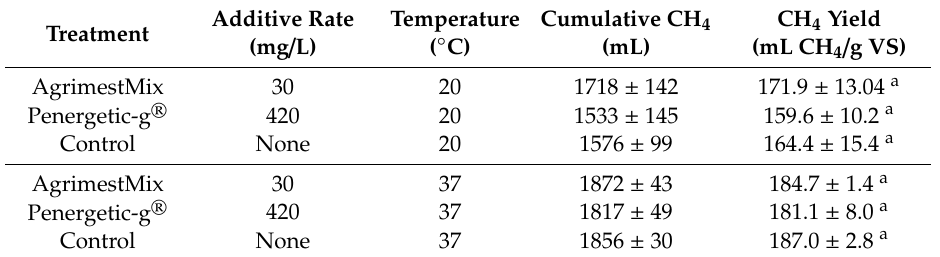
Figure 6. Cumulative methane produced (mL CH 4 ) from BMP batch cultures containing liquid dairy manure over a 30-day incubation at 37 ◦ C ( a – c ) and a 90-day incubation at 20 ◦ C ( e – g ). The bottles contained AgrimestMix (AM) ( a , e ), Penergetic-g ® at 420 mg / L ( b , f ), or a control without additive ( c , g ). Each timeseries shows the mean ± standard deviation (n = 3), and the grey line is the average production from inoculum. The total methane yields for each treatment are compared in the bar graph, with error bars showing the standard deviation ( d , h ). Table 1. Cumulative net methane production from manure in study #2. Within each incubation temperature, methane yields followed by the same superscript letter are not significantly di ff